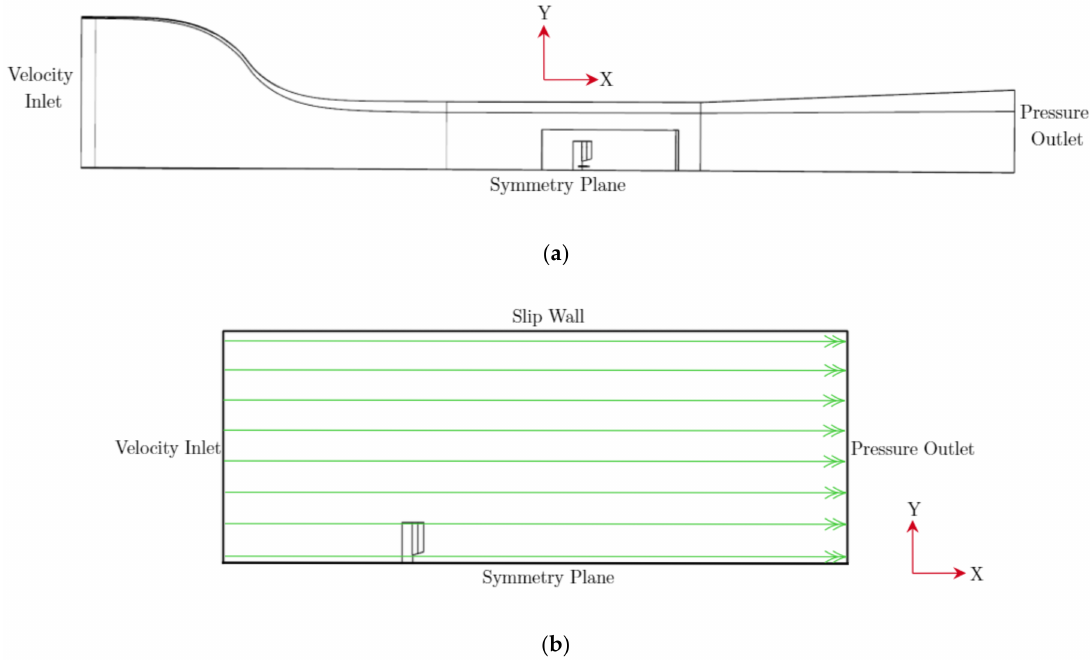
Figure 7. The boundary conditions applied for the straight-line condition. ( a ) Numerical validation variant; ( b ) Full-scale straight- line